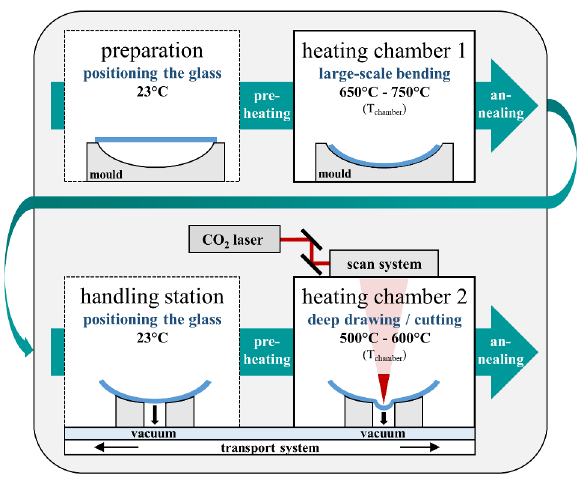
Fig. 2. Principle of the hybrid forming process of thin glass.